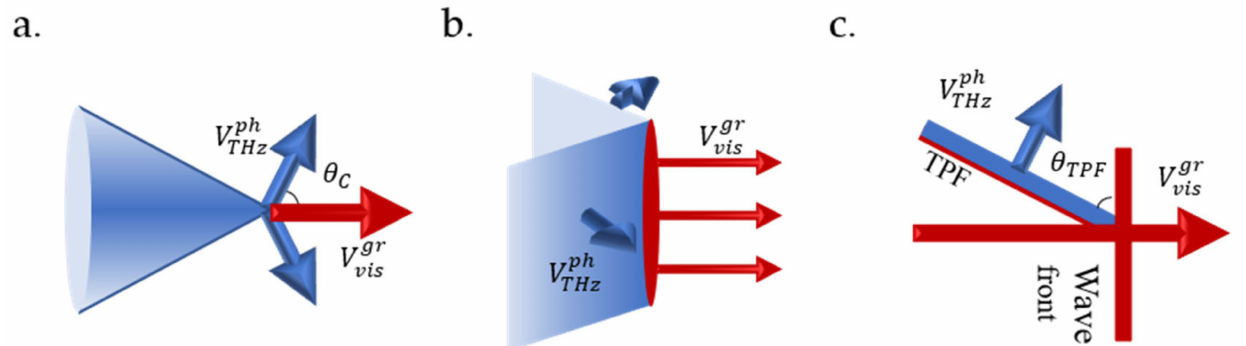
Figure 2. Experimental setup of Cherenkov geometry and the TPF technique. ( a ) Schematics of Cherenkov geometry. The Si prism couples the THz from thin-slab LN. ( b ) Schematics of the TPF technique. An intense femtosecond pump pulse is incident on the reflective grating with high groove density (1000–2000 lines/mm) and gets angularly dispersed. The optical axis of the LN crystal is perpendicular to the polarization from the grating with the highest reflection, so a half-wave plate is inserted to rotate the beam polarization. A double-lens telescope with 4f geometry is used to re-image the diffracted pump pulse in the LN crystal. ( c ) The spot size of THz generated from LN is magnified by the telescope, and then focused down by mirror. The THz field is detected by an EO sampling setup. [Reprinted/Adapted] with permission from [53] © The Optical Society, and [29] © AIP Publishing.